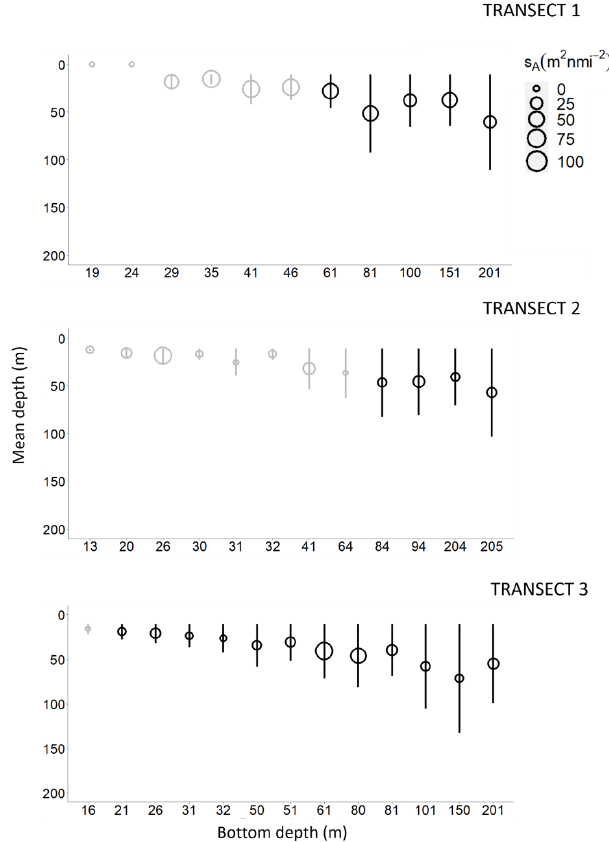
Figure 5. Sound-scattering layer (SSL) mean depths (empty cir- cle) according to their bottom depth, with their associated thickness (line, in meters) and SSL mean nautical area scattering coefficient (NASC or s A in m 2 nmi − 2 ), along transect 1 (south), transect 2 (intermediary), and transect 3 (north) during nighttime (black) and daytime (gray) sampling